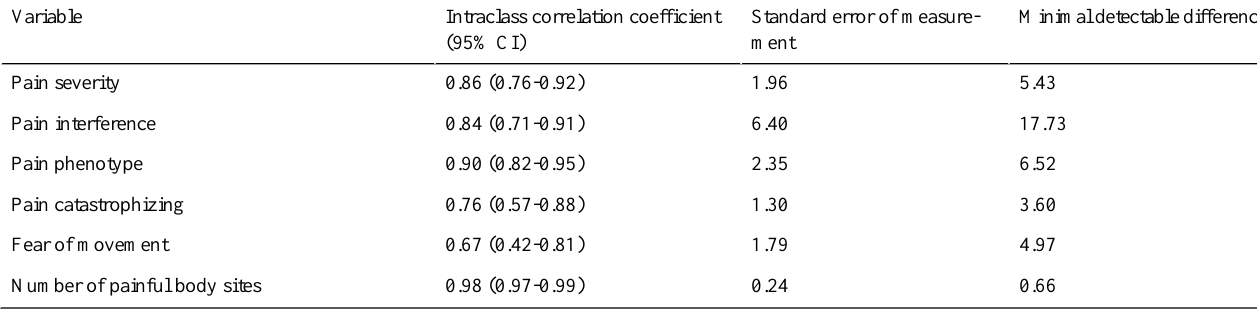
Table 6. Test-retest reliability and standard error of measurement of the AvaliaDor app.